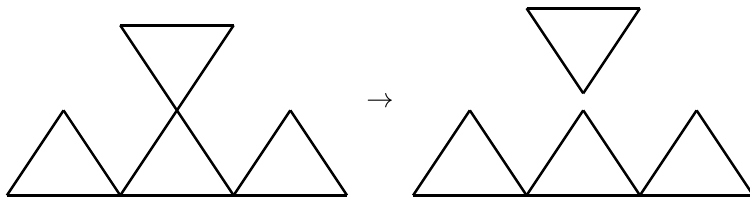
Figure 7. The diagrams show when an even planar Mandelstam variable vanishes, the diagram on the left separates into two parts as shown on the right, and each of them contains a reducible bubble. Note that here we omit the external legs in the diagram, which should be attached to external corners of